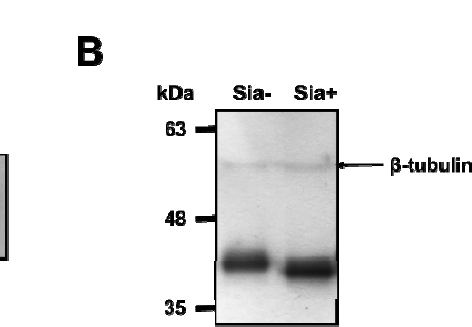
Figure 2. MHC-I on human DCs is sialylated. (A) MHC-I immunoprecipitates (IP) show reactivity with SNA lectin. MHC class I immunoprecipitates were obtained from whole cell lysates of DCs from 3 different individuals IP products were probed with anti-MHC-I (W6/32 antibody) (left) and SNA lectin to confirm the presence of α 2,6-linked sialic acids (right) (B) Molecular weight of MHC-I heavy chain is decreased after sialidase treatment. Whole cell lysates of human DCs were treated with sialidase (Sia+) overnight at 37 ºC and separated by SDS-PAGE and then probed for anti-MHC class I, using the W6/32 antibody in Western blot. Untreated cell lysates (Sia-) were used as control and β -tubulin was used as loading control.